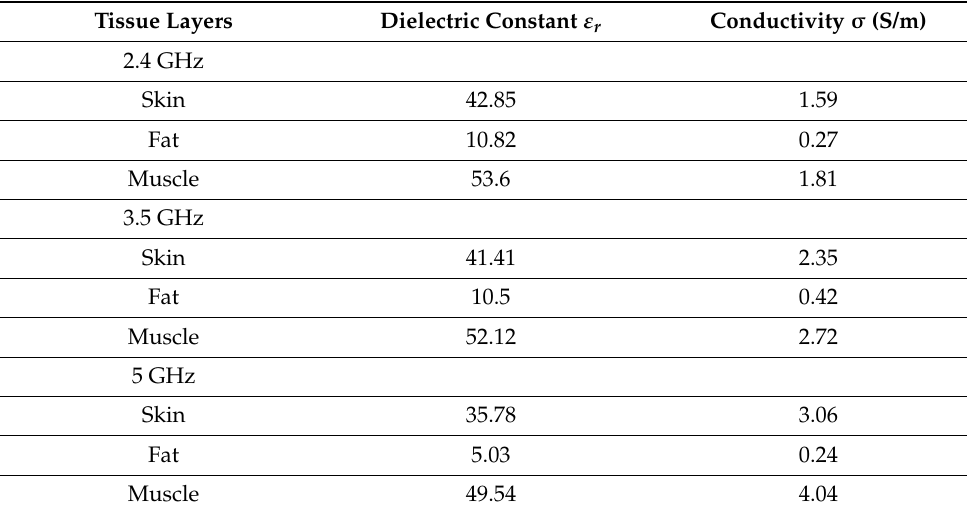
Table 6. Dielectric characteristics of tissue layers for different frequencies. Reprinted with permission from ref. [45]. Copyright 2021 ETE Journal of